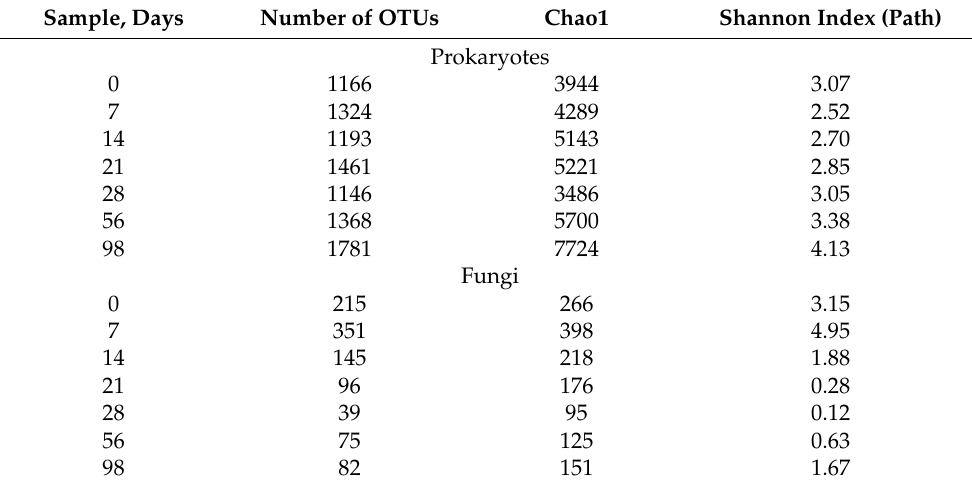
Table 2. Biodiversity of prokaryotic and fungal communities. Sample,